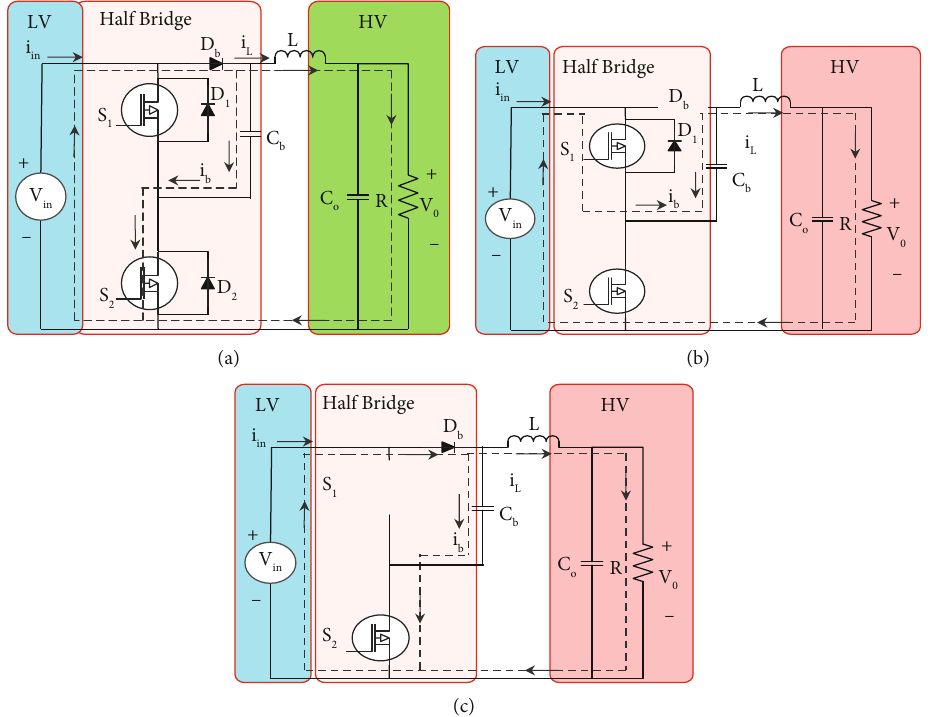
Figure 1: FKYBC: (a) topology, (b) state 1 operation, and (c) state 2 operation.